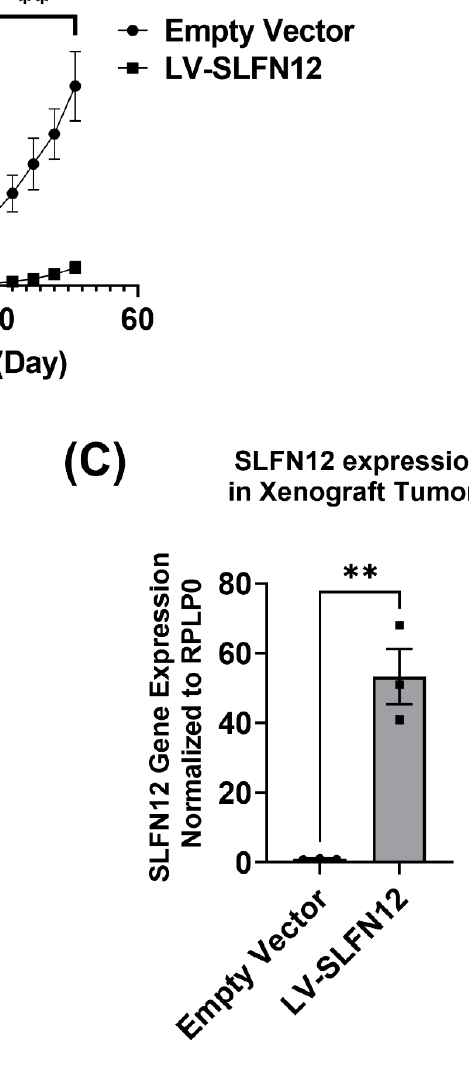
Figure 1. Schlafen 12 reduces mammary xenograft tumor growth in vivo. ( A ) Average tumor volume as a function of time in NSG mice that were orthotopically injected with MDA-MB-231 cells overexpressing SLFN12 (LV-SLFN12) compared to NSG mice injected with control MDA-MB-231 cells (empty vector) over a 12-week period (n = 6, ** p ≤ 0.01, student t -test). ( B ) NSG mice injected with MDA-MB-231 cells overexpressing SLFN12 (LV-SLFN12) showed significantly increased latency compared to mice injected with control empty vector cells (n = 6, ** p ≤ 0.01, student t -test). ( C ) mRNA analysis by Primer-probe RT-qPCR of SLFN12 expressions in LV-SLFN12 mammary xenograft tumors that were processed for RNA-seq analysis compared to the control empty vector mammary xenograft tumor; RPLP0 was used as a reference gene (n = 3, ** p ≤ 0.01, *** p ≤ 0.001). Data are expressed as mean ± SEM.